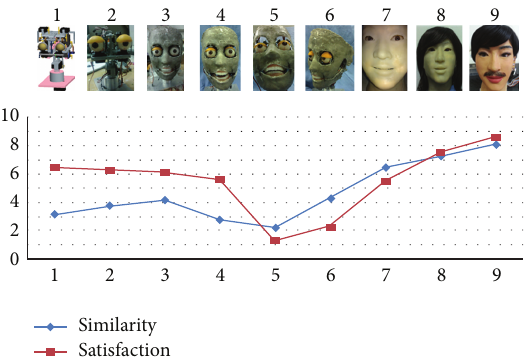
Figure 5: Results of our humanoid robot